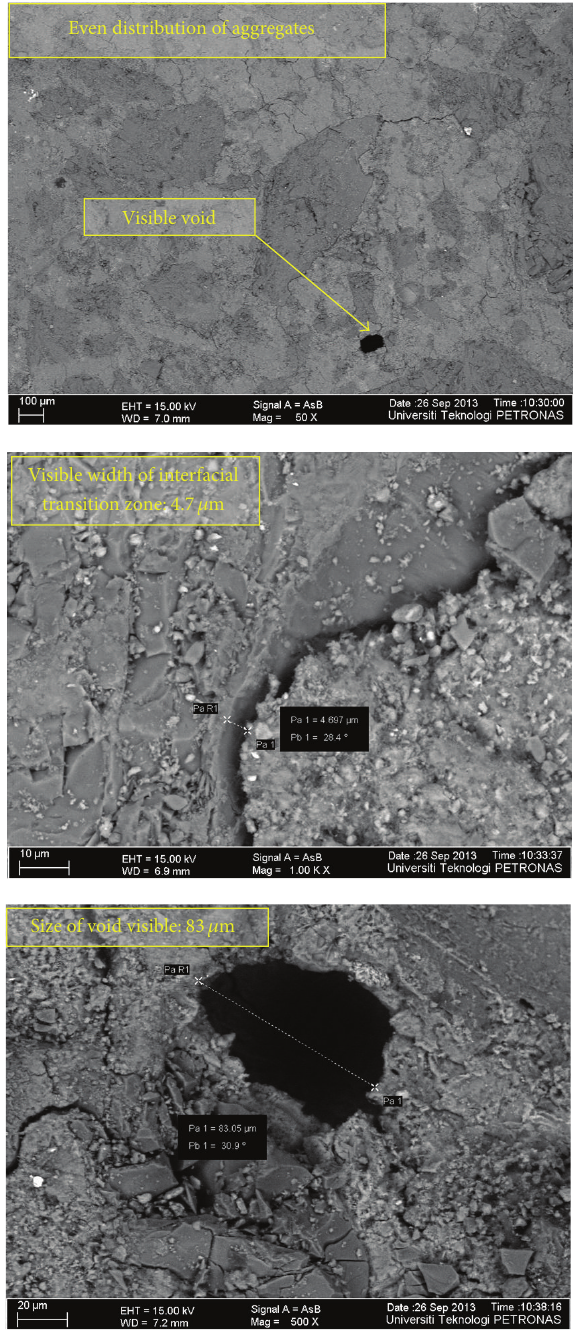
Figure 9: Microstructure of concrete mix “P-0.” Figure 10: Microstructure of concrete mix